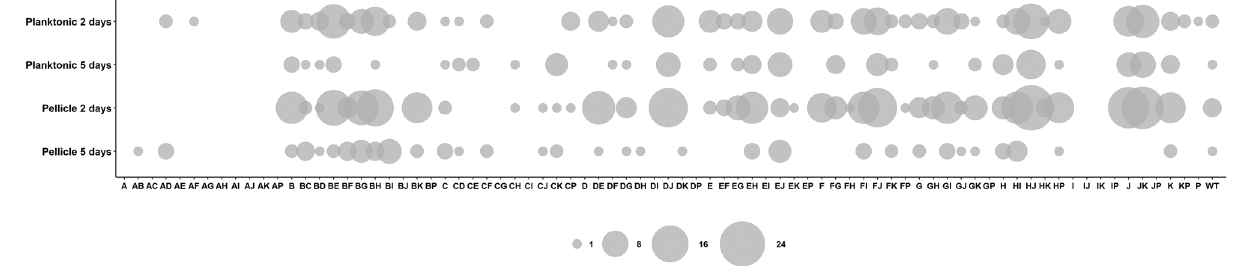
Fig. 3 Bubble graph representation of mutant frequencies in the evolved populations. Bubble sizes represent the number of populations (from n = 24) in which the given rap – phr mutant has a frequency higher than the putative input